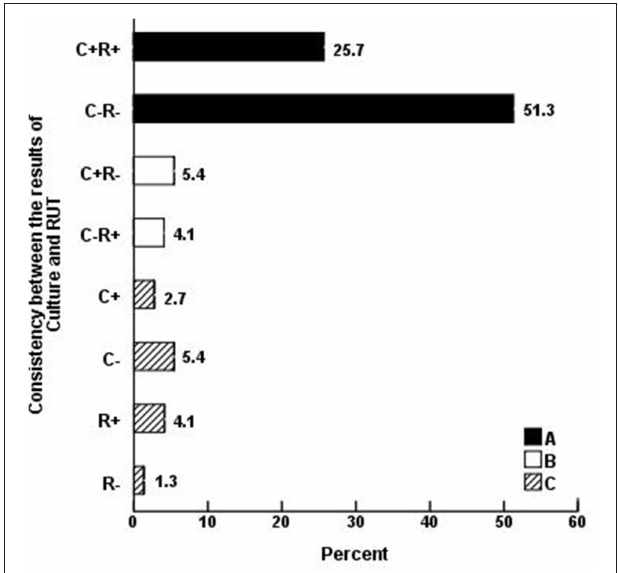
FIGURE 1 | Consistency between the results of H. pylori culture (C) and RUT (R) in 74 gastric biopsies. The frequency of biopsies with consistency in the results of RUT and culture ( A: 57, 77%), including both positive (19, 25.7%) and both negative (38, 51.3%) was higher than those without consistency in the results of two tests ( B: 7, 9.5%), including 4 (5.4%) culture-positive and 3 (4.1%) RUT-positive ( p = 0). The remaining ( C: 10, 13.5%) biopsies included 2 (2.7%) culture-positive, 4 (5.4%) culture-negative, 3 (4.1%) RUT-positive, and 1(1.3%)